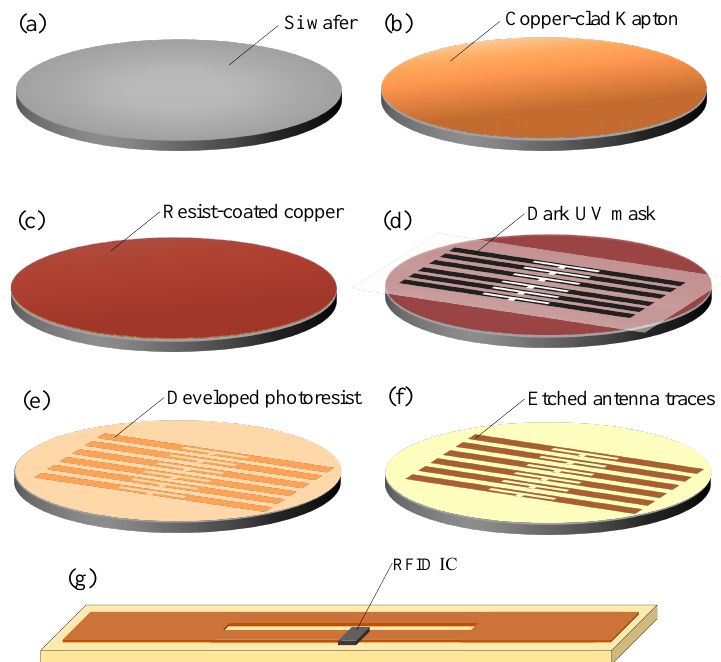
Figure 2. Fabrication steps of the Kapton RFID filament for textile-integration: ( a ) planar silicon wafer used as a carrier, ( b ) adhere copper-clad Kapton laminates to the Si wafer, ( c ) spin-coat photoresist, ( d ) UV exposure using a dark mask, ( e ) develop photoresist showing the traces pattern, ( f ) expose antenna traces after wet etching, ( g ) RFID filament tag with the mounted RFID